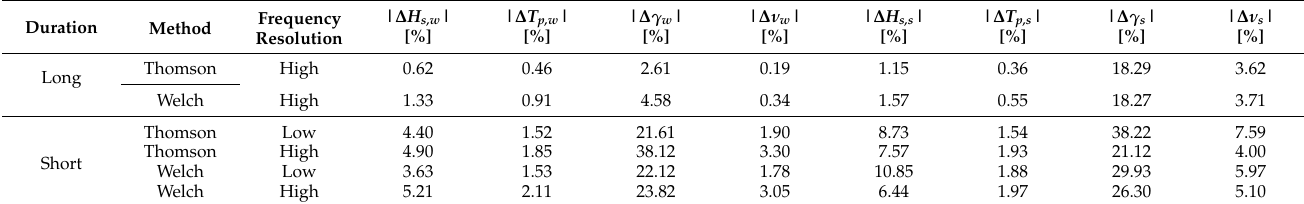
Table 9. Results